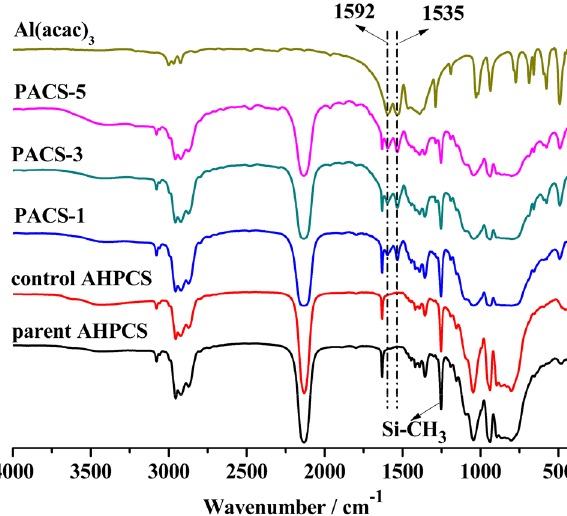
Figure 2: FT - IR spectra of parent AHPCS, control AHPCS, PACSs, and Al ( acac ) 3